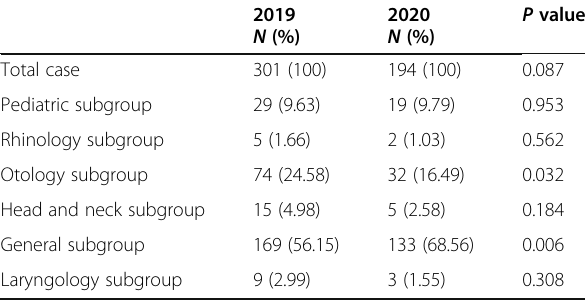
Table 5 Comparison of new outpatient visits between 2019 and 2020 in each Otolaryngology subgroup